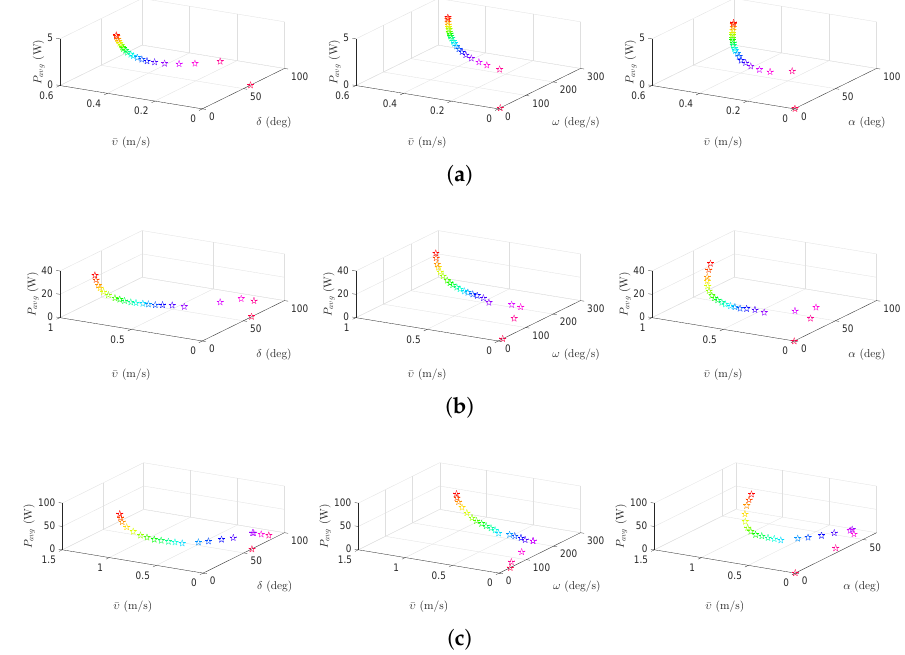
Figure 6. Optimal gait parameters for the lateral undulation motion pattern for the USR, considering the negative work effect: ( a ) 3D plots of optimal gait parameters for robot with n = 5 links; ( b ) 3D plots of optimal gait parameters for robot with n = 10 links; and ( c ) 3D plots of optimal gait parameters for robot with n = 20 links. Colors illustrate different weights of the objective